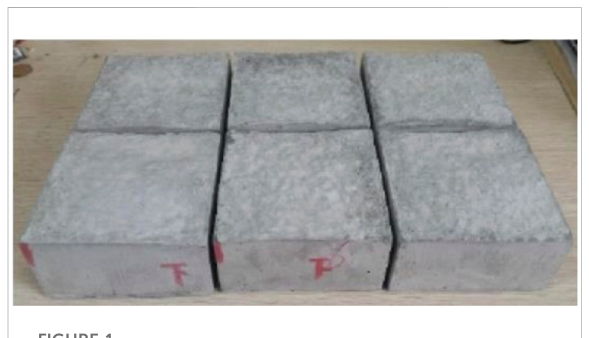
FIGURE 1 Upper and lower parts of the splitting structural plane (Qu 2018).